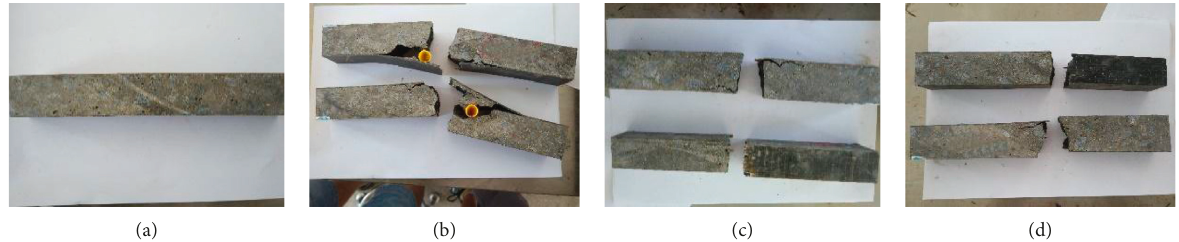
Figure 14: Fracturing behaviors of beam specimens of resin composite overlay reinforced with different fibers at 15 ° C. (a) Blank. (b) CF. (c) GF. (d) BF.